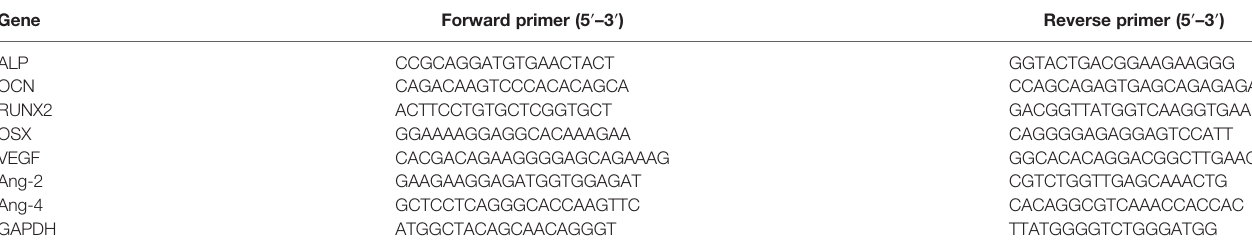
TABLE 1 | Real-time PCR primer sequences used in the study. Gene Forward primer (5 ′ – 3 ′